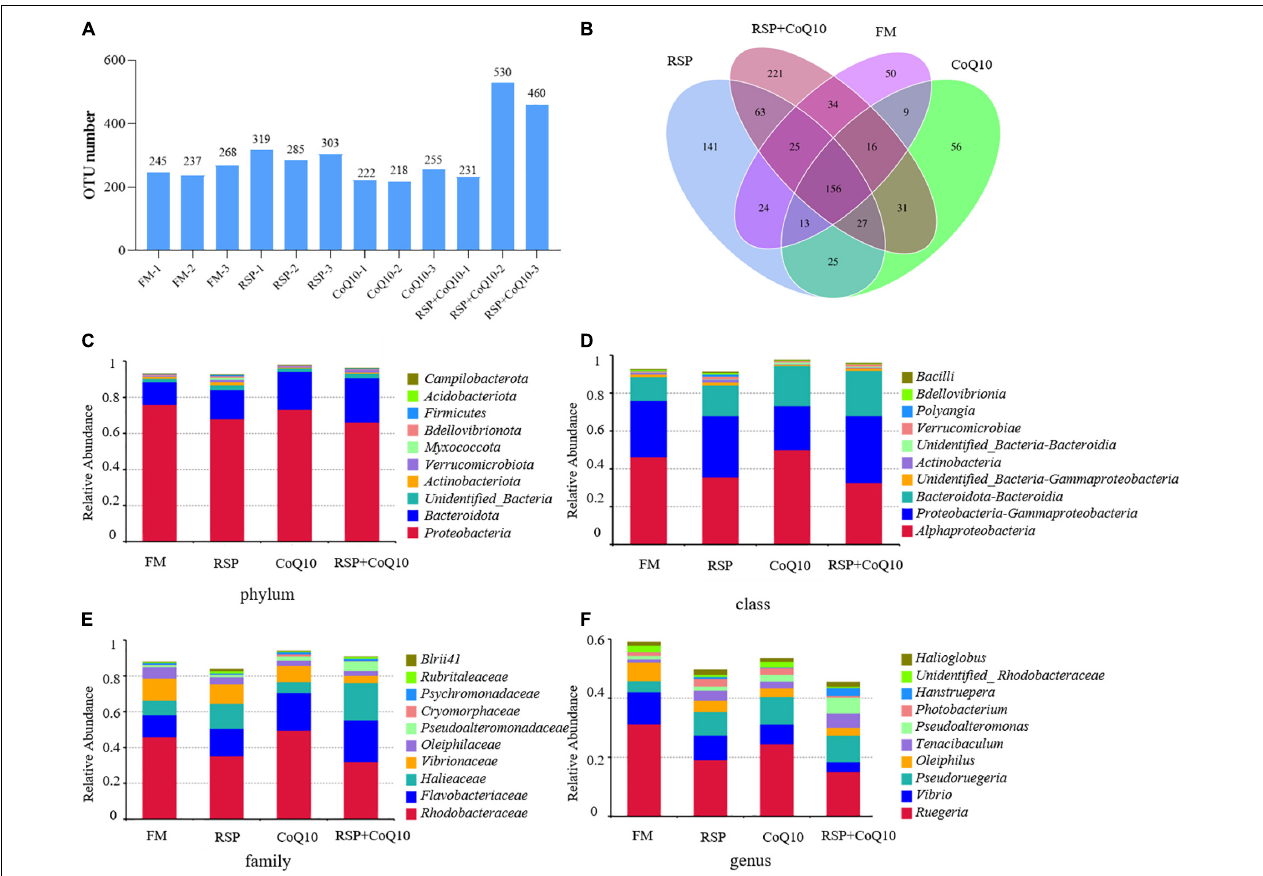
FIGURE 3 | Taxonomic analysis of intestinal microbiota in L. vannamei fed four different diet treatments. (A) Distribution map of OTU number in samples from different diet treatments. (B) Comparison of OTUs in the four diet treatments by Venn diagram. Relative abundance of bacterial community in all diet treatments at (C) phylum, (D) class, (E) family and (F) genus levels in different diet treatments. AL, ageratum-liquid; OTU, operational taxonomic unit